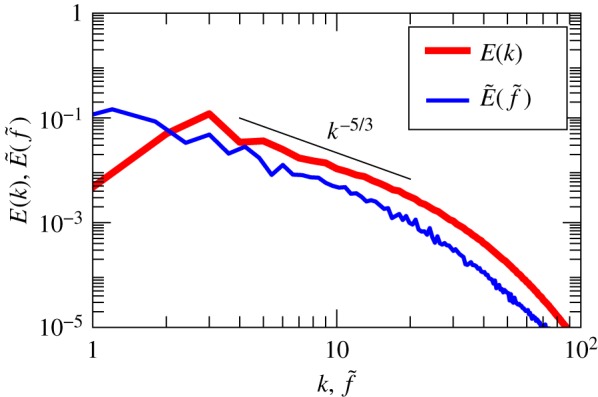
For hydrodynamic turbulence simulation with U0=10z^, plot of the wavenumber spectrum E(k) and scaled frequency spectrum for the real-space probes: f→f~=f(2π)/U0 and E(f)→E~(f~)=E(f)U0/(2π).